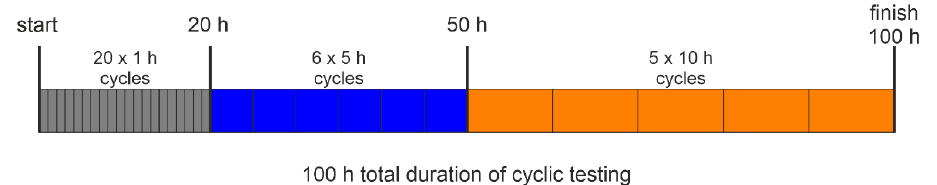
Figure 1. Schematic illustration of the cyclic oxidation testing with different cycle durations of 1 (highlighted in dark grey), 5 (highlighted in blue) and 10 h (highlighted in orange).